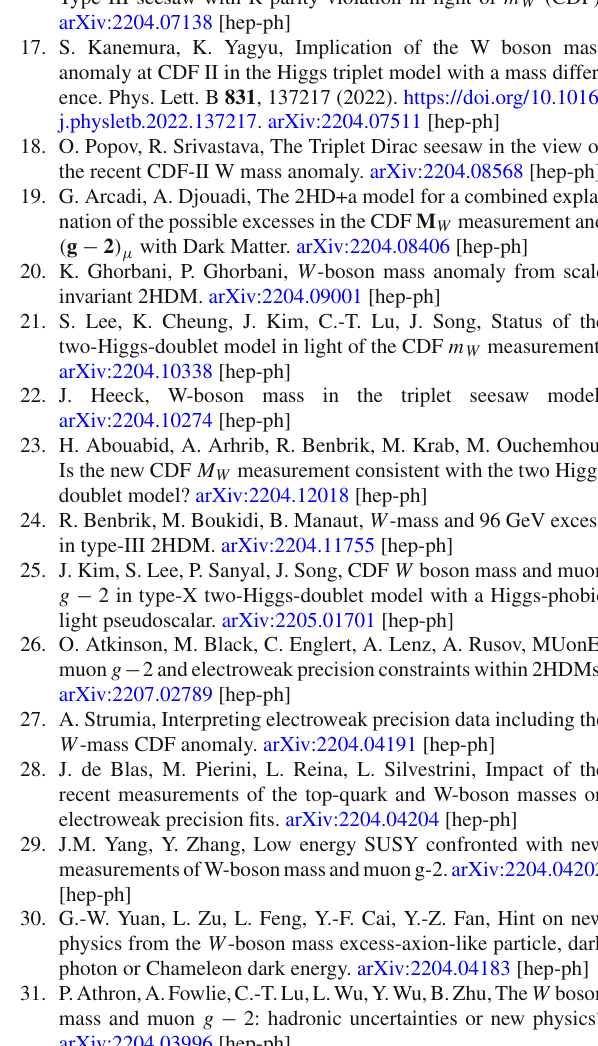
m H + < m A ( m H ++ > m H + > m A ) in the left (right) panel. We do not show the parameters for | λ 5 | > 10 in drawing the curves. The color bands are the same as those in Fig.